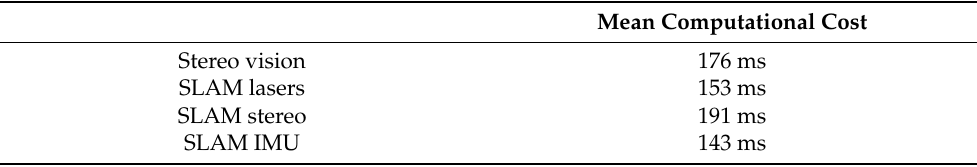
Table 6. Mean computational cost of the analysed